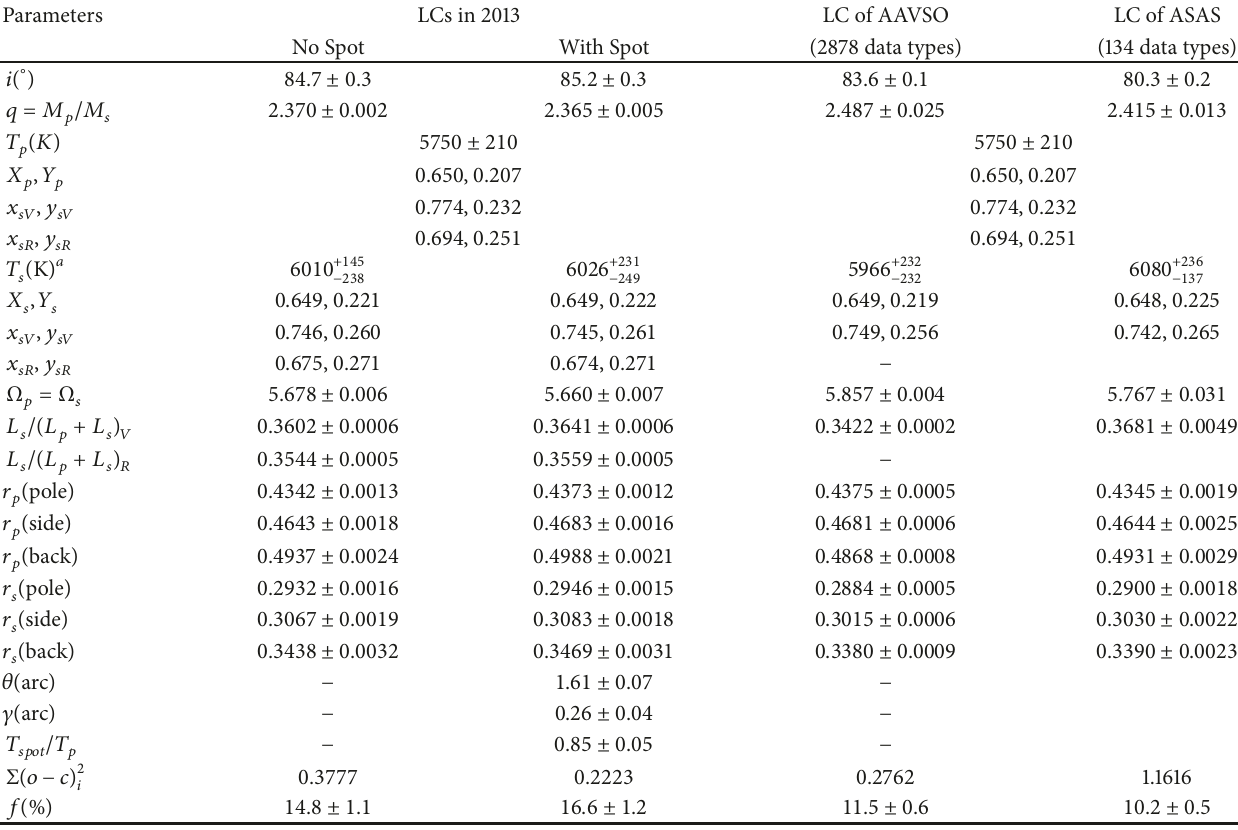
Table 4: Photometric solutions for MT